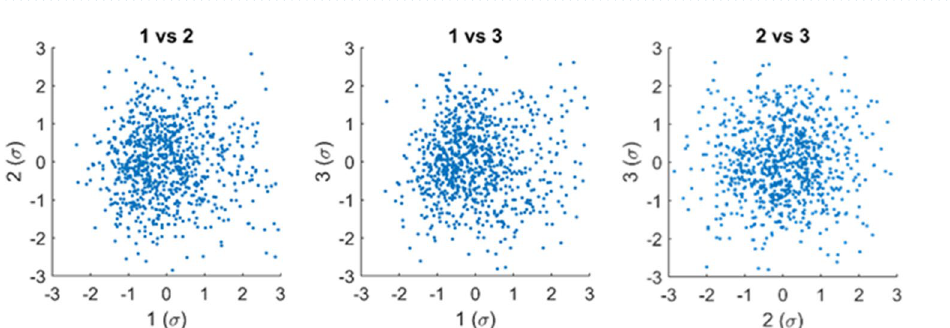
Figure 7. Principal component weights in standard deviations plotted against each other for modes